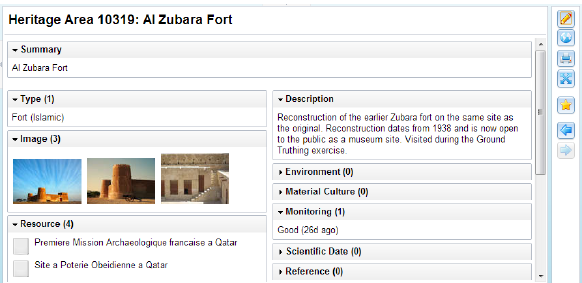
Figure 5. Record detail browser